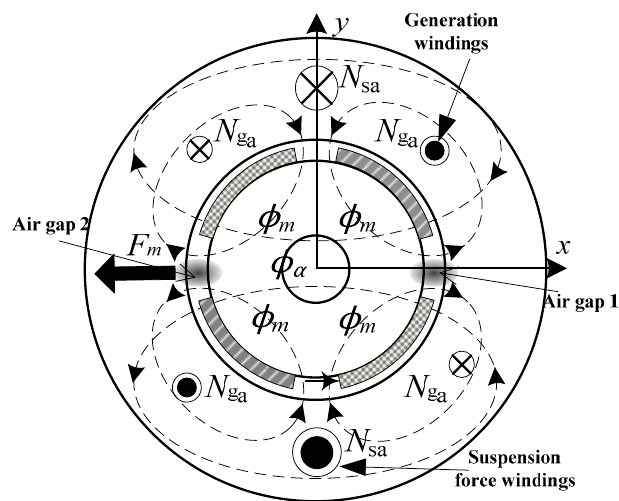
Figure 2. The suspension principle of HEBPMG.